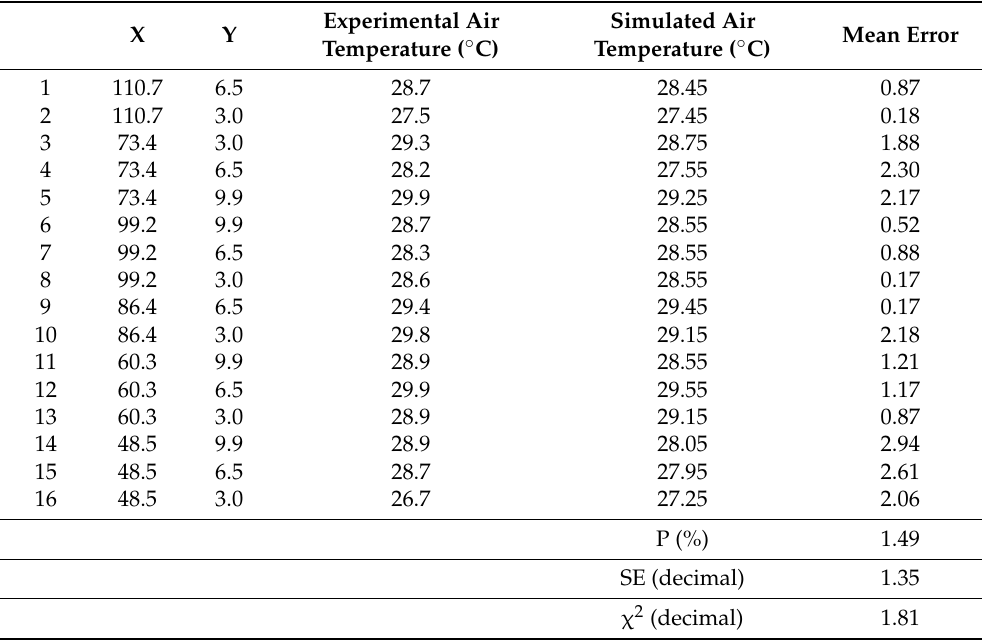
Table 1. Comparison of the air temperature values ( ◦ C) inside the broiler house obtained experimen- tally and simulated by the